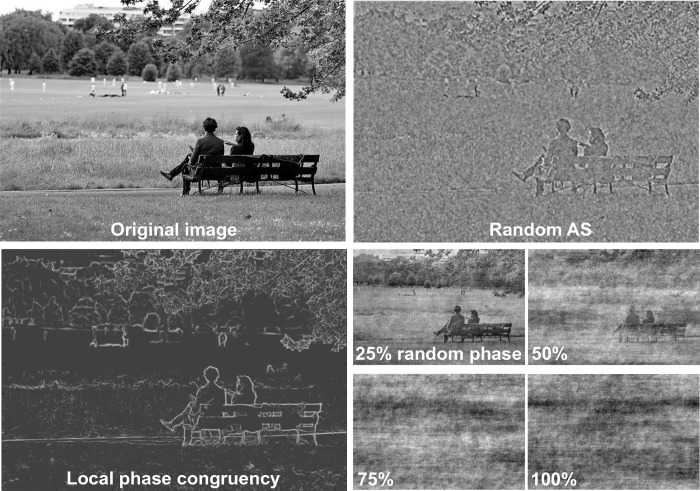
The upper row depicts an intact scene (top left) and the same scene with the phase spectrum left intact but with amplitude spectra wholly randomized (top right). The lower panel depicts the local phase congruency (LPC) map of the intact image (bottom left), where darker greys indicate relatively lower phase congruency and lighter grays indicate higher LPC, corresponding to local edge and corner detail. The bottom right panel illustrates variants of the original image with an unaltered amplitude spectrum, though with varying amounts of phase randomization. Note the degradation of edge and corner detail as phase randomization increases.